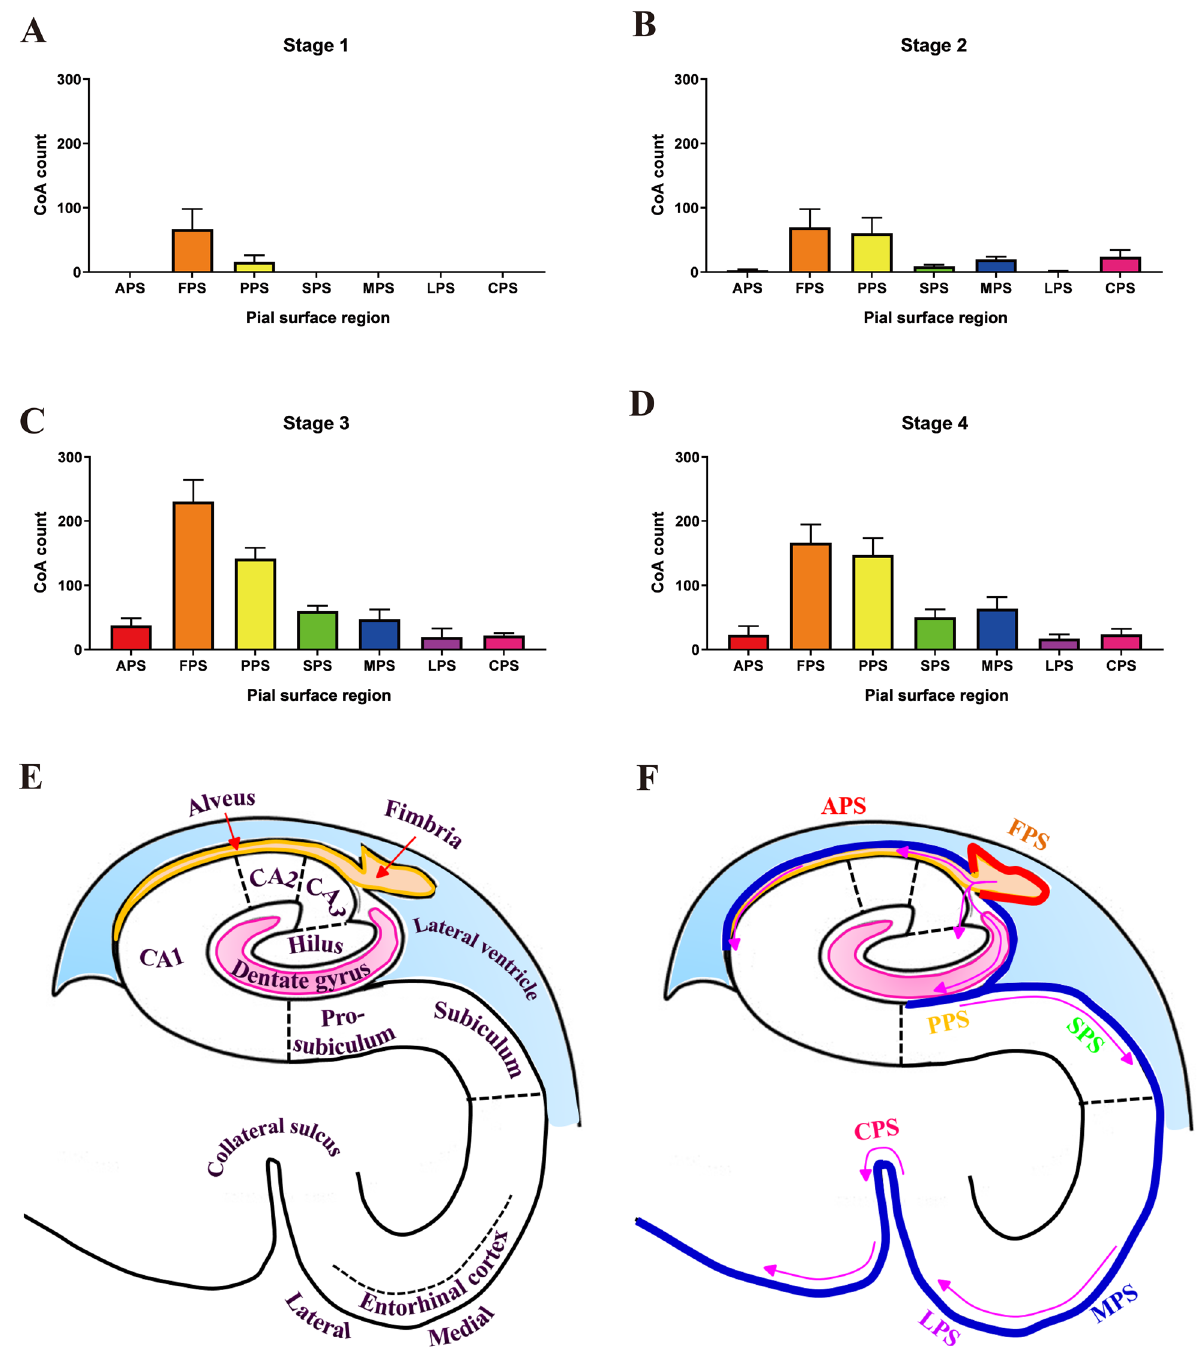
Figure 2. CoA count in seven pial surface regions at stage 1 ( A ), stage 2 ( B ), stage 3 ( C ) and stage 4 ( D ). Mean ± SEM. E, Schematic diagram of the hippocampus, modified from Yang Y, et al. (2008) 40 . F, Proposed progression of CoA along the pial surface; red curve indicates highest CoA density in the fimbria pial surface region; blue curve indicates the decreased CoA density along the pial surface when spreading bilaterally from the fimbria, as pointed by the purple curved arrows. APS alveus pial surface, FPS fimbria pial surface, PPS prosubiculum pial surface, SPS subiculum pial surface, MPS medial entorhinal cortex pial surface, LPS lateral entorhinal cortex pial surface, CPS collateral sulcus pial